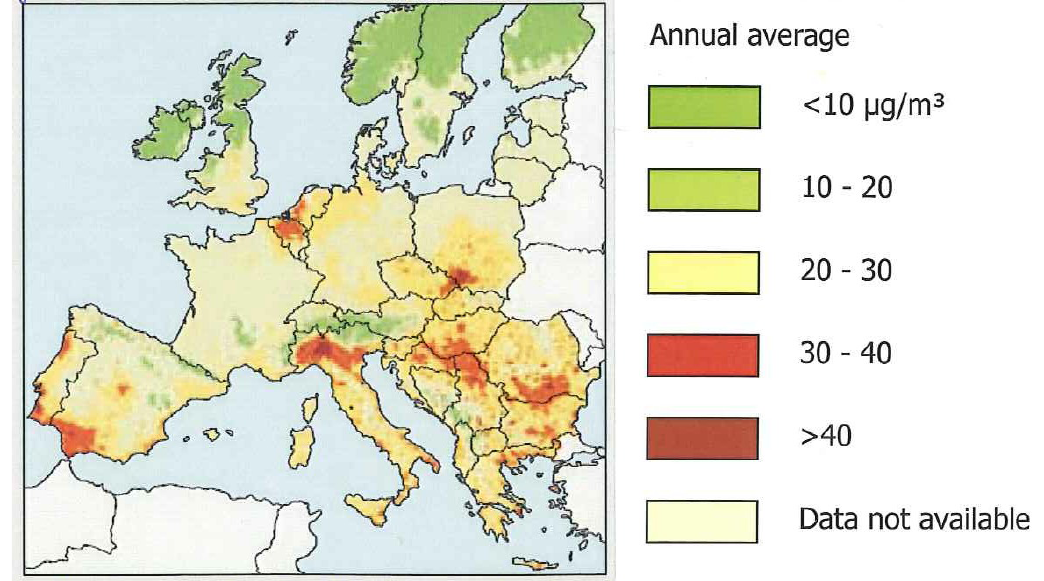
concentrations in Europe, 10